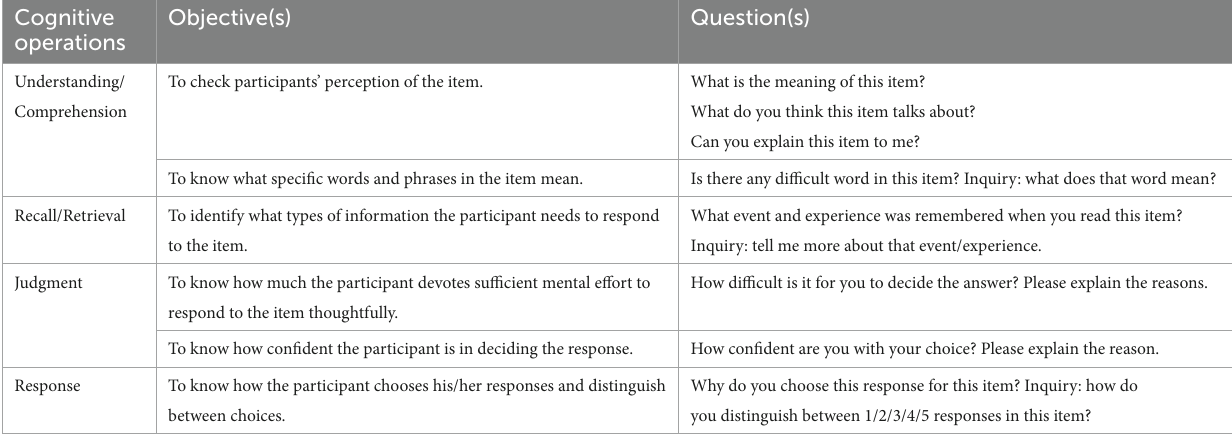
TABLE 1 Cognitive interview guide based on Tourangeau Cognitive model (Willis, 2015). Cognitive